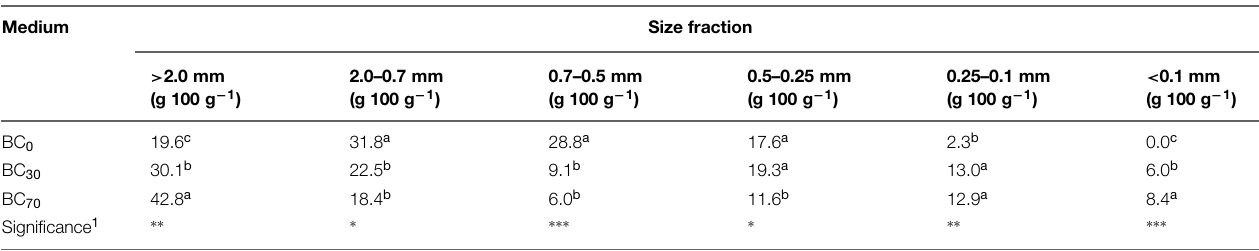
TABLE 1 | Weight of different particle-size classes of media measured before Pelargonium growing cycle. Medium